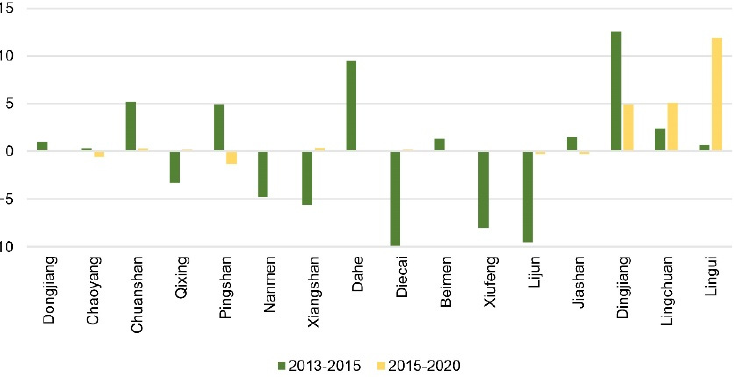
Figure 6. Ratio of land consumption rate to population growth rate(LCRPGR) from 2013 to 2020 in townships of Guilin.